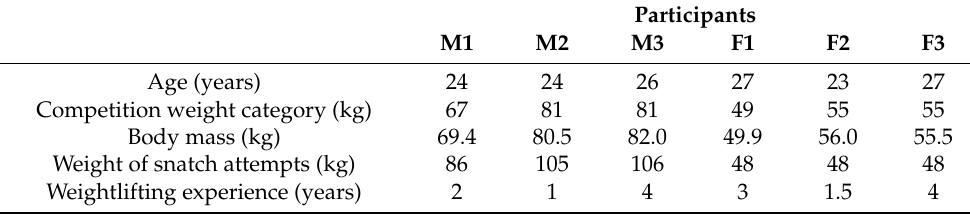
Table 1. Participant characteristics of male and female weightlifters in the Singapore national team.